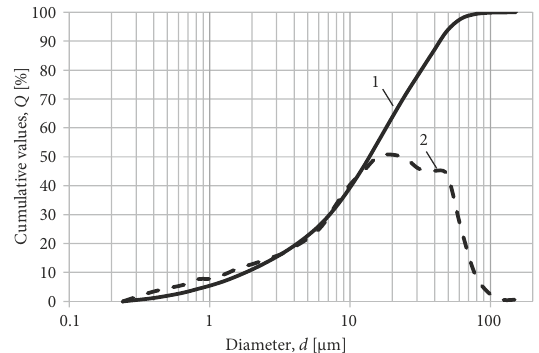
Figure 1. Cement CEM I 42.5 R particulate levels distribution by size: 1 – distribution of the relative amount of particles according to size; 2 – distribution of absolute quantity of particles by size